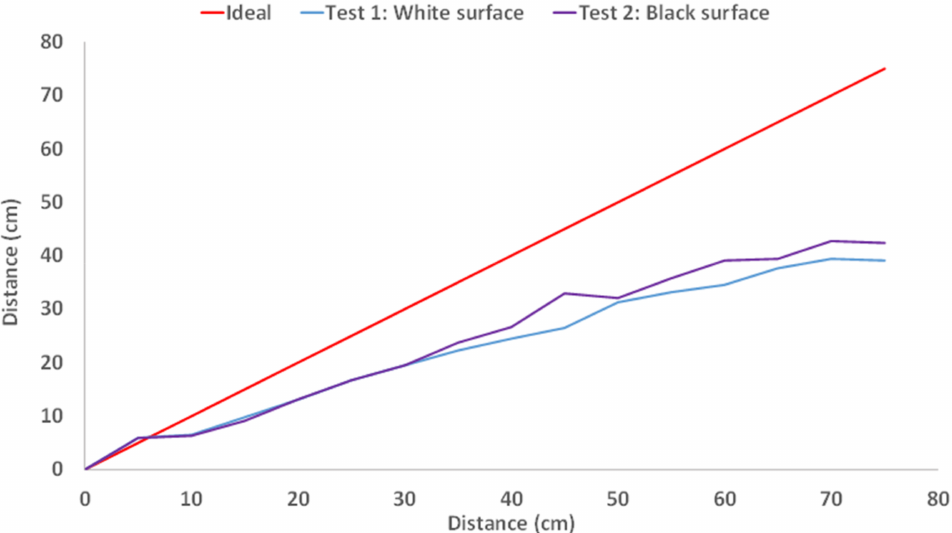
Figure 22. Results of proximity sensor for measuring the height of water in the main channel.